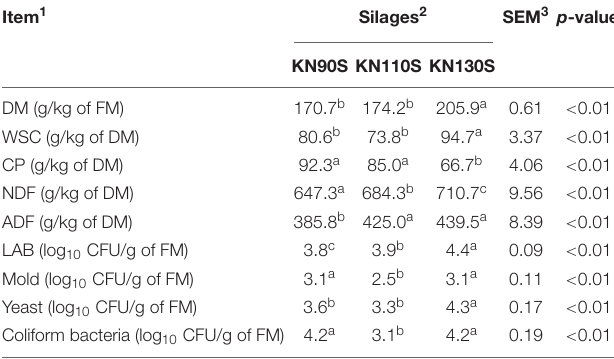
TABLE 1 | Chemical characteristics and attached microorganisms of king grass before